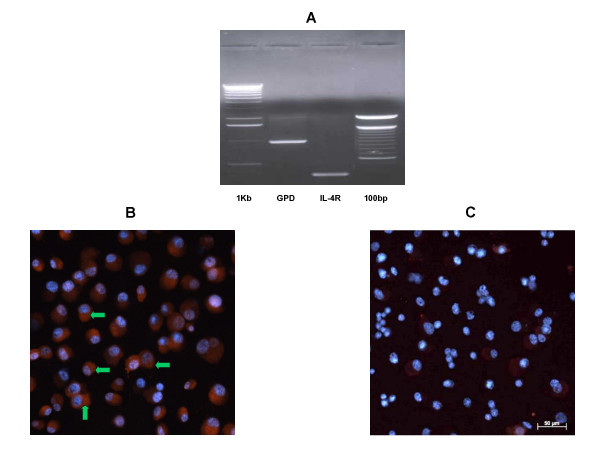
(a) RT-PCR analysis of IL-4R mRNA expression from NCI-H650 cells. Total RNA was extracted from confluent cultures and analyzed for the presence of IL-4R and GAPDH transcripts by RT-PCR. The amplified products were run on 1% agarose-ethidium bromide gels. Bands at 335 bp (IL-4R) and 1000 bp (GAPDH) were observed. Immunohistochemical determination of IL-4Rα upon permeabilized NCI-H650 cells using (b) rabbit polyclonal anti-human IL-4Rα antibody (c) and non-immune rabbit IgG serum (control). Secondary antibody incubations were performed with Alexa Fluor (568 nm)-labeled mouse antibody. Cells were counterstained with DAPI and photographed using dapi: rhodamine filters at 25:2000 ms exposure. Block arrows in (1b) are indicative of specific staining to IL-4 receptors on cell surface.